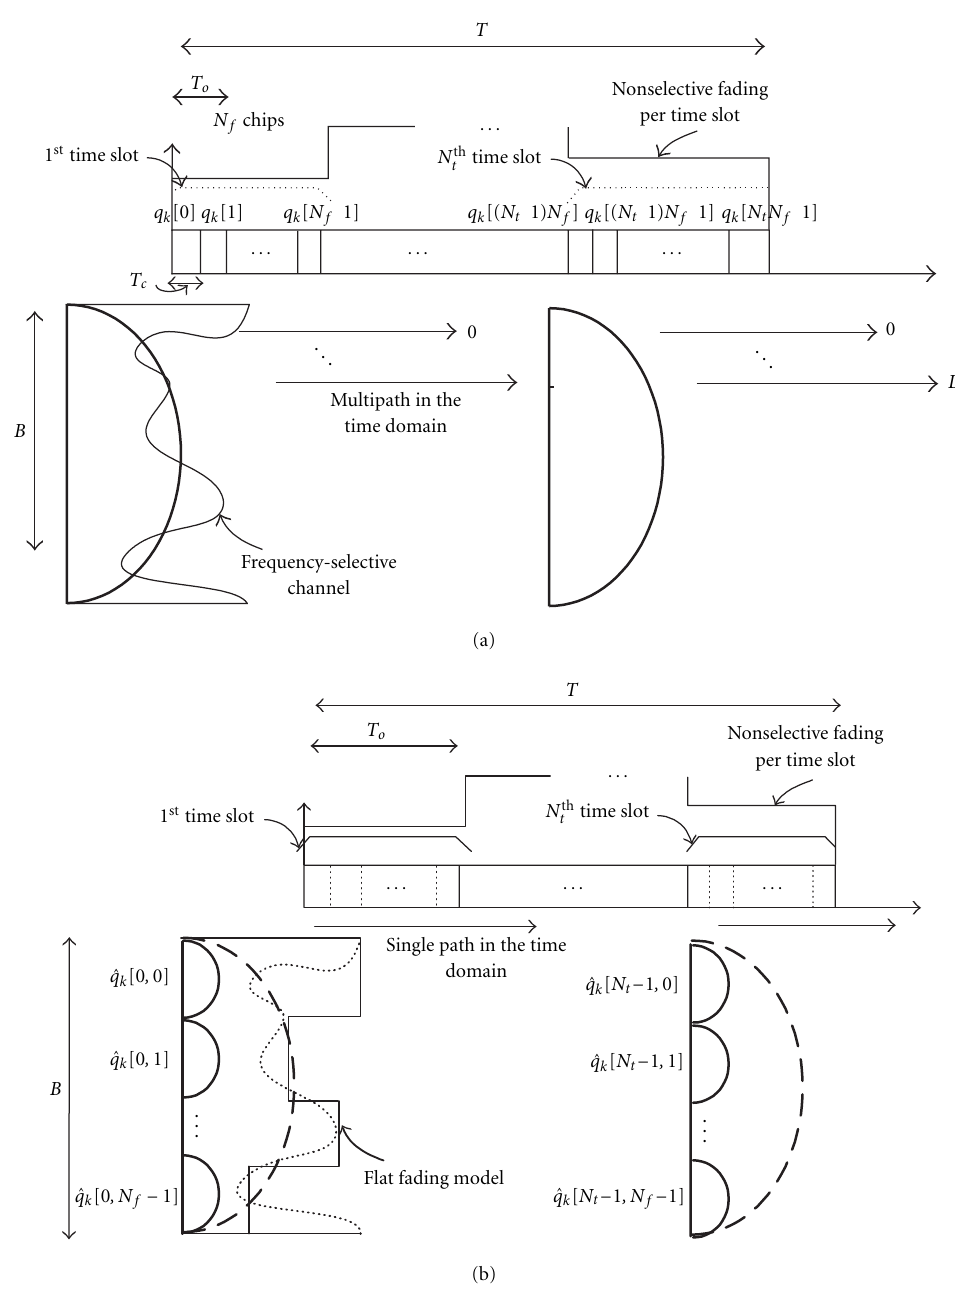
Figure 6: Diagonalizing TFS channel via TF-CDMA system starting from a DS-CDMA system. The symbol duration is divided into N t time slots, each containing N f time samples that fade similarly. To diagonalize the TFS channel, each basis waveform bandwidth is reduced by N f and its duration is increased by N f so that the new basis waveforms encounter flat fading in time and frequency. (a) DS-CDMA system. (b) TF-CDMA